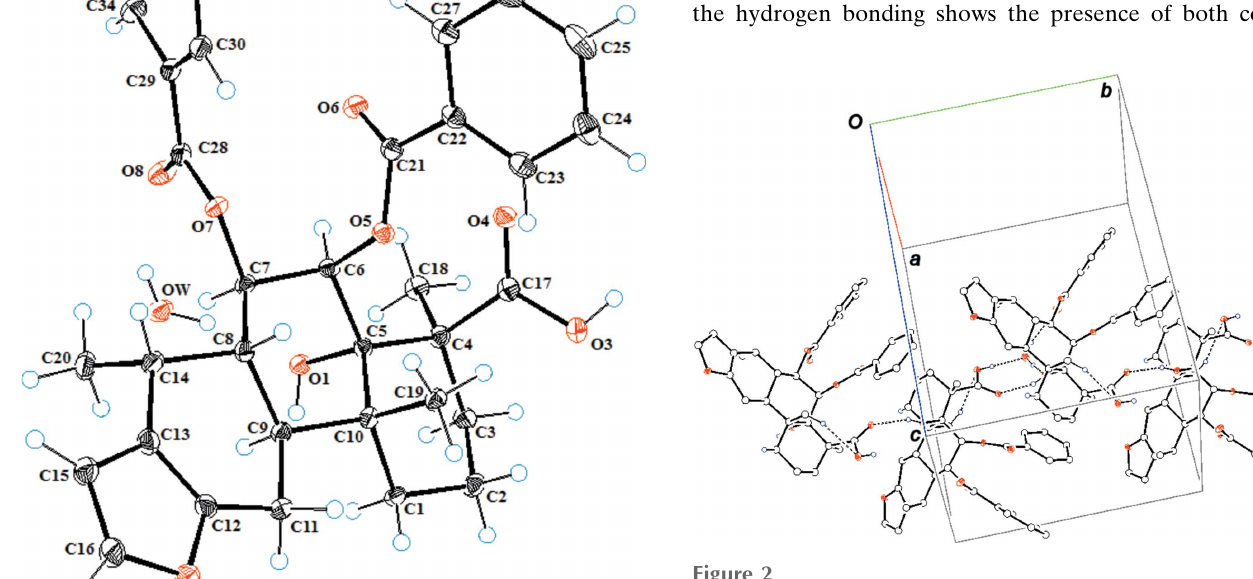
Figure 1 The molecular structure of the title compound with displacement ellipsoids drawn at the 50% probability level.